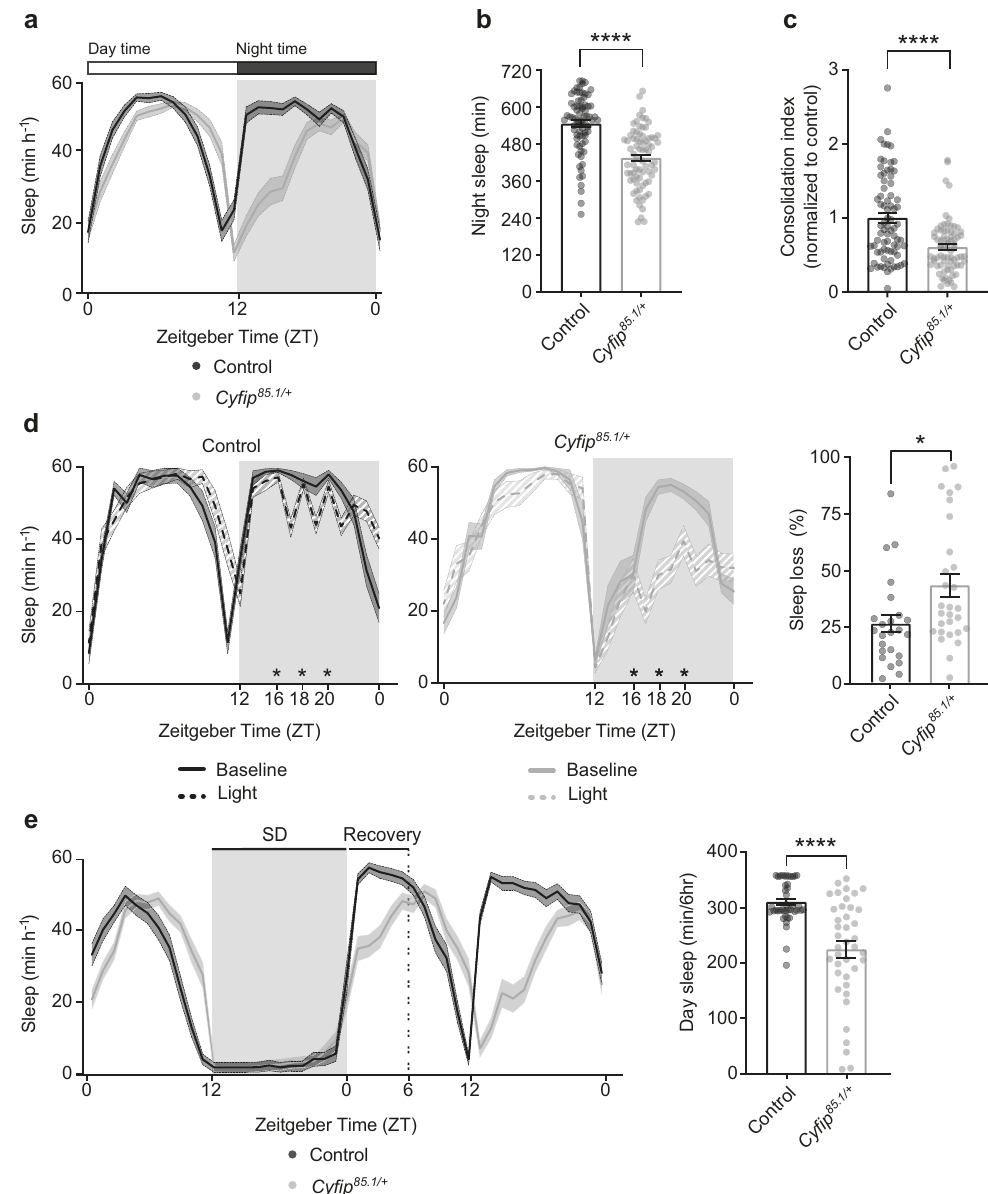
Fig. 1 | CYFIP regulates the amount and quality of night-time sleep. a Representative sleep pro fi le of control (black, n =38) and Cy fi p 85.1/+ (gray, n =39) fl ies.Mean±S.E.M. b , c Quanti fi cationofnightsleepamount( b )andConsolidation Index (CI) at night ( c ) in control ( n =75) and Cy fi p 85.1/+ ( n =75) fl ies. Two-tailed unpaired Student ’ s t test, **** p <0.0001. Mean ± S.E.M. d Waking response after sleep perturbation at ZT16, ZT18 and ZT20 (marked by “ * ” ) in control ( n =24) and